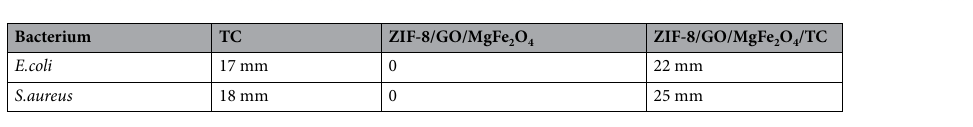
Table 1. The antibacterial activity of TC, ZIF-8/GO/MgFe 2 O 4 , ZIF-8/GO/MgFe 2 O 4 /TC.